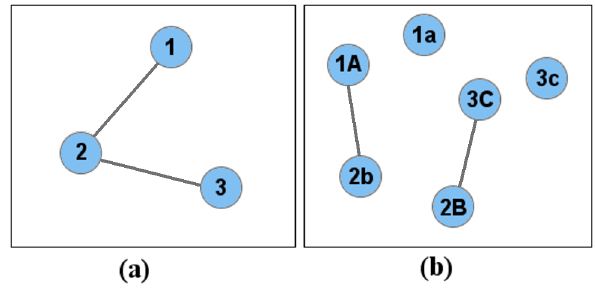
Figure 6. Comparison of SNP network construction methods. The network in (a) represents each SNP by a single node, as is done by previous approaches, and the network in (b) employs a node for each of the SNP alleles. Allele ‘A’ for SNP 1 is correlated with allele ‘b’ of SNP 2, and allele ‘B’ of SNP 2 is correlated with allele ‘C’ of SNP 3. Allelic information is lost in a standard network (a), resulting with an incorrect linking of allele 1A with 3C. The BlocBuster approach also enables allele- specific testing of bloc